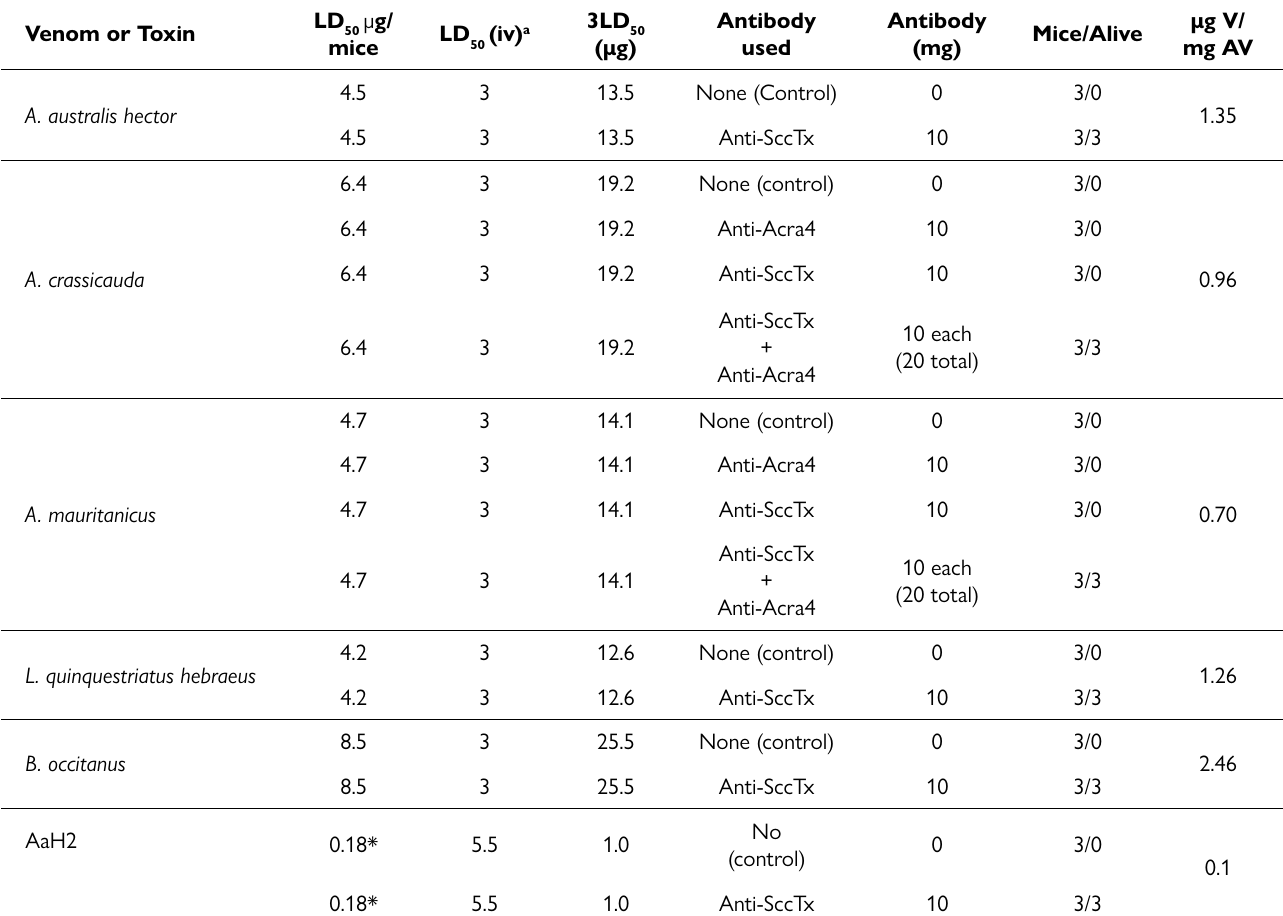
Table 4. Venom and toxin neutralization using antibodies again HisrAcra4 and